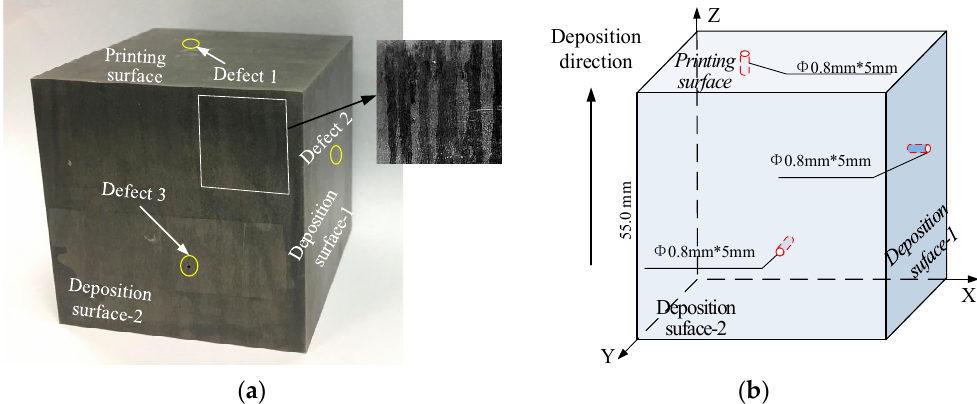
Figure 6. 3D-print specimen of TC 18 titanium alloy. ( a ) The actual specimen and defect distribution; ( b ) demonstration of the specimen and defects’ sizes.